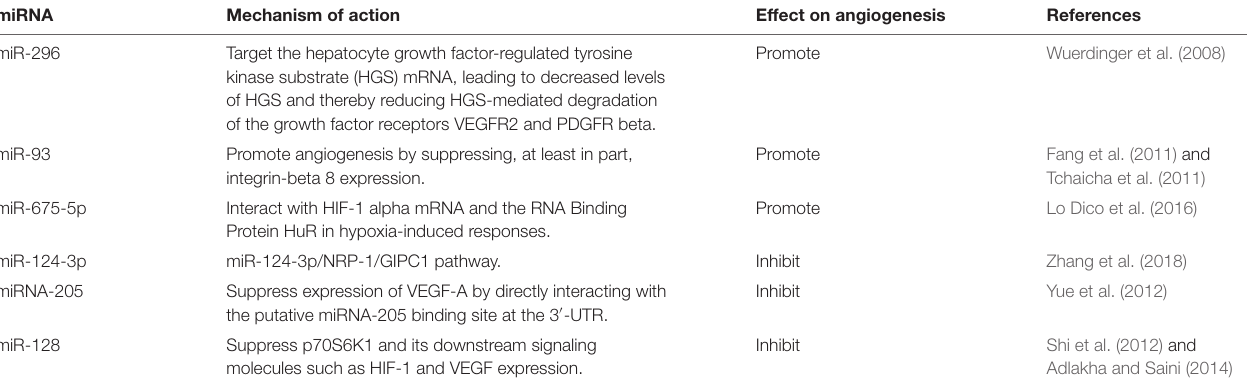
TABLE 1 | miRNAs involved in the regulation of glioma angiogenesis. miRNA Mechanism of action Effect on angiogenesis